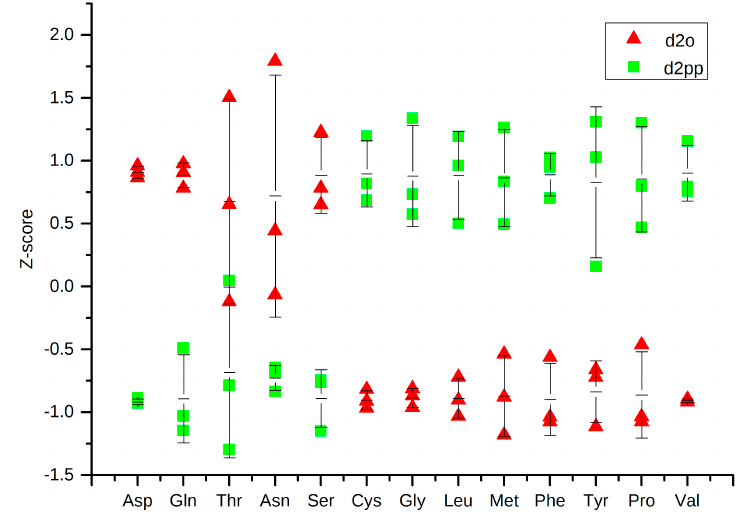
Figure 7. Dot plot of amino acid levels in groups d2o and d2pp, showing the z-scores with average and error bars of each substance.